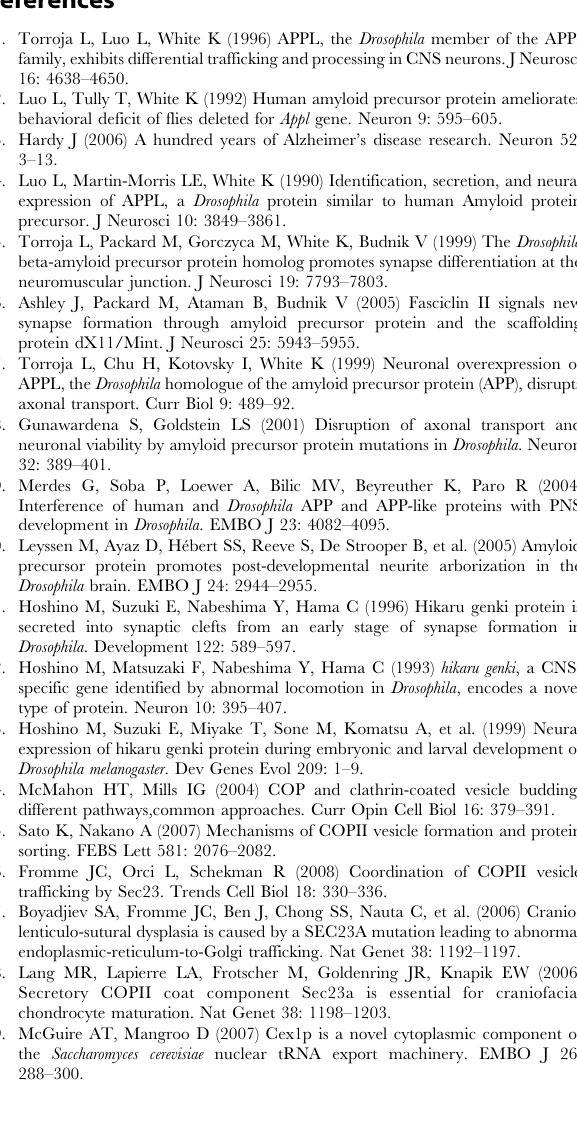
Figure S4 Correlation of the signal intensities of APPL and KDEL immunostaining. Statistical analysis of the immunostaining intensities of APPL and KDEL in the 10 m m square regions of the single optic lobe. A significant correlation was observed between the staining intensities of these two antibodies (r = 2 0.581, Pearson’s correlation coefficient, p , 0.01, N= 30). Figure S5 Genetic mosaic analyses of the subcellular localization of exogenously expressed APPL-FLAG. Accumulation of APPL- FLAG was observed in the yata mutant clones (A–D, surrounded by dotted lines, arrows in B), which were marked by the absence of GFP (A). Scale bar: 5 m m. Figure S6 Profiles of Sec23p immunostaining. (A) Intensity profiles of Sec23p immunostaining of the yata mutant shown in Figure 7A. Radically elevated Sec23p signals are shown in the